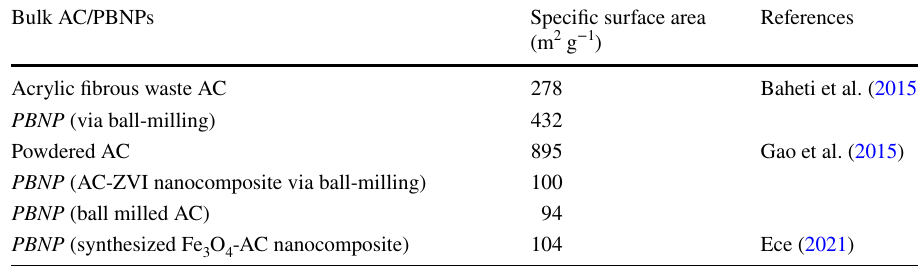
Table 1 Summary of specific surface area properties of bulk AC and derived